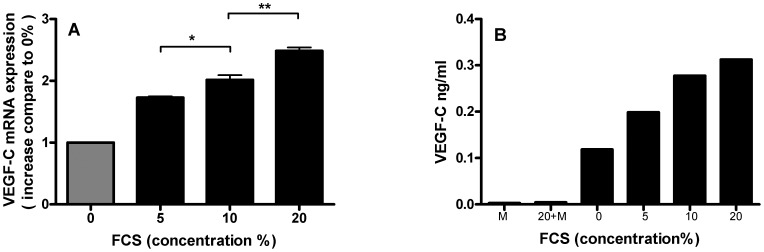
Human proximal tubular epithelial cells (HK-2) express VEGF-C upon serum stimulation in a dose-dependent fashion.After incubation of HK-2 cells by fetal calf serum, a dose-dependent induction of VEGF-C was observed both at mRNA level by RT-qPCR (A) and at protein level measured by ELISA in culture supernatant. mRNA induction (A) is expressed as increase in VEGF-C mRNA message compared to cells cultured in the absence of fetal calf serum. Graph represents three independent experiments performed in duplo. The VEGF-C ELISA (B) have been performed twice in duplo. Graph shows one representative example, with bars being the mean of duplicates. M (cell culture medium) and 20+M (20% FCS in medium without incubation with cells) were measured as controls (B). (*p<0.05; **p<0.01).